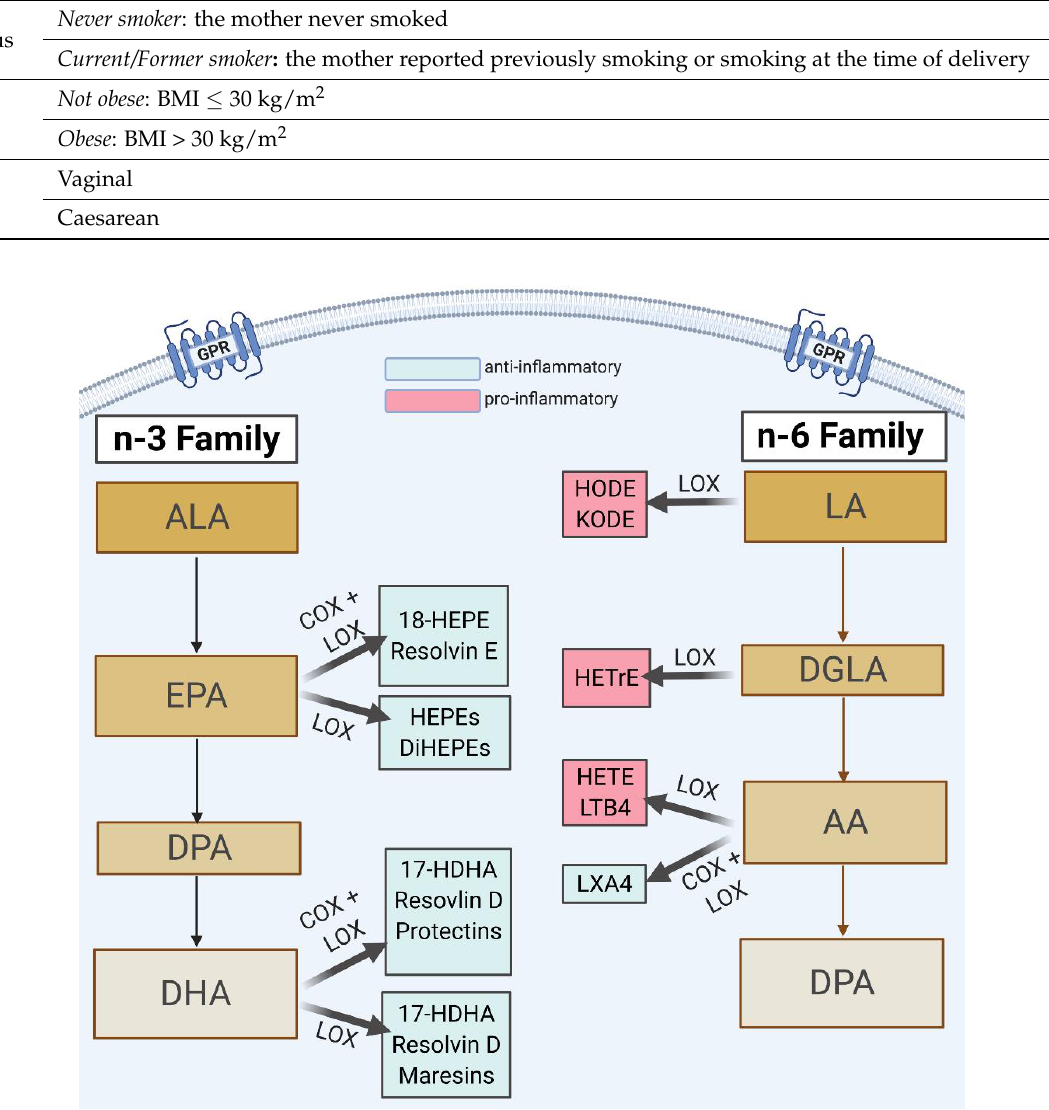
Figure 3. Demonstration of lipoxygenase enzymatic breakdown of metabolite with or without contributions from other pathways. Metabolites included in this study were formed through the lipoxygenase actions of 5-, 12-, and 15-LOX with or without modifications from other enzymes. This figure highlights metabolites that undergo breakdown by multiple enzymes. Created with BioRender.com (30 Dec 2021). Table 12. n-3 FA metabolites and abbreviations.